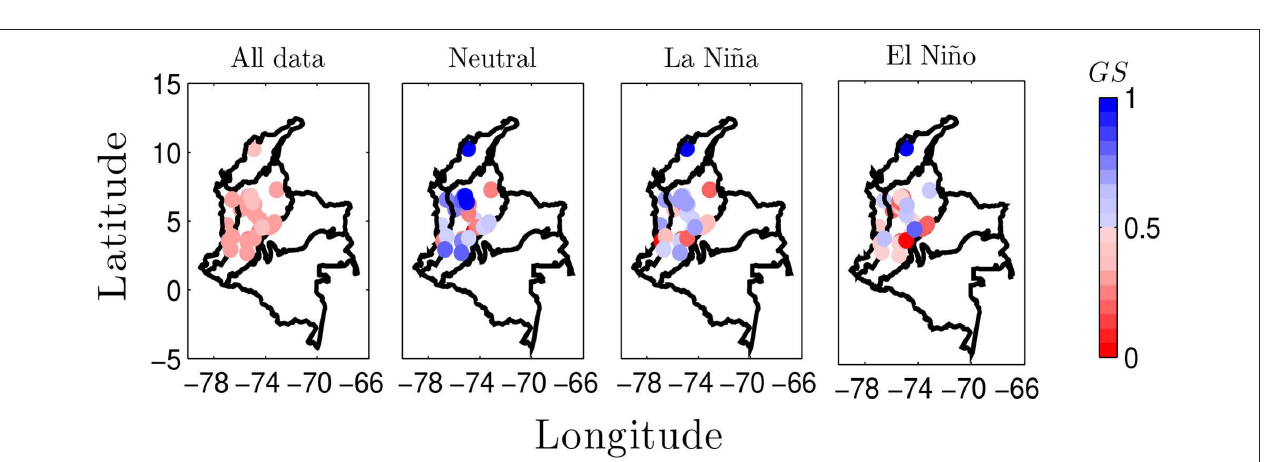
FIGURE 10 | Generalized synchronization index between SST3.4 anomalies and river flow anomalies from the IDEAM and XM datasets, period